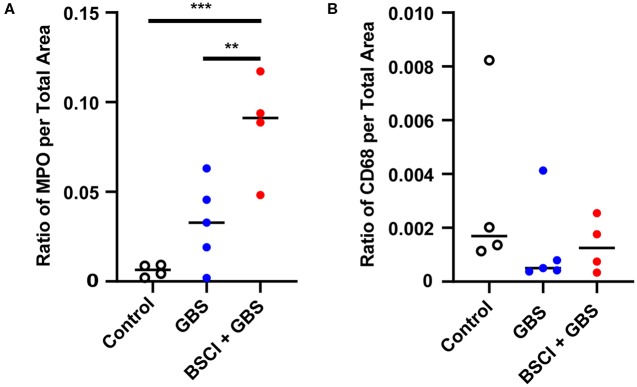
Quantitation of immunostaining for MPO and CD68 in the fetal lung. The area of immunostaining for MPO (A) and CD68 (B) is shown within the fetal lung parenchyma as quantitated using Visiopharm software. The MPO immunostaining area was significantly greater in the BSCI treatment group compared to GBS alone or saline controls. No significant difference was observed in the CD68 immunostaining area between the BSCI and other groups in the fetal lung. The outlier in the saline group in panel B was a newer saline control performed as part of this study. **p < 0.01, ***p < 0.001, one-way ANOVA with Tukey's post-hoc correction.